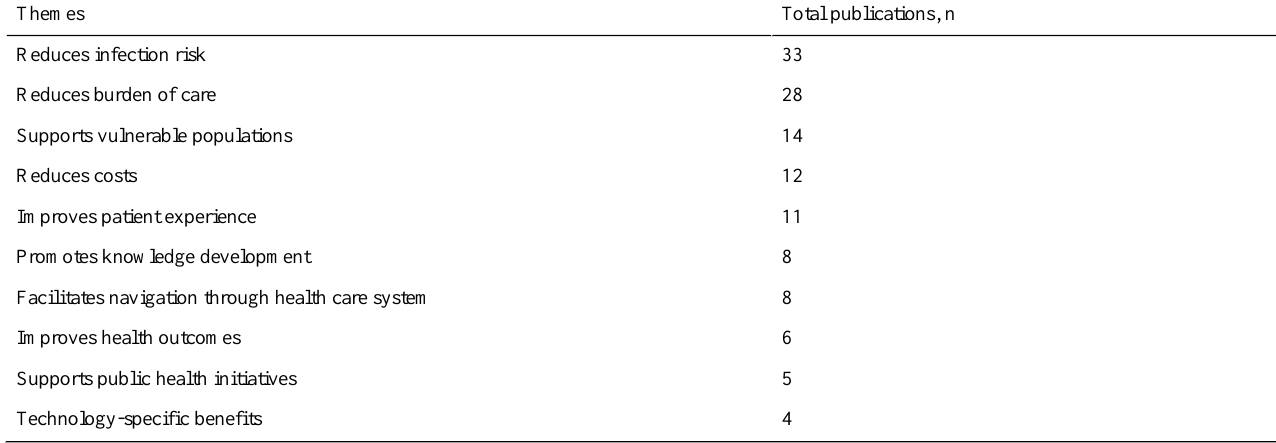
Table 3. Perceived benefits of remote monitoring technologies for patients with